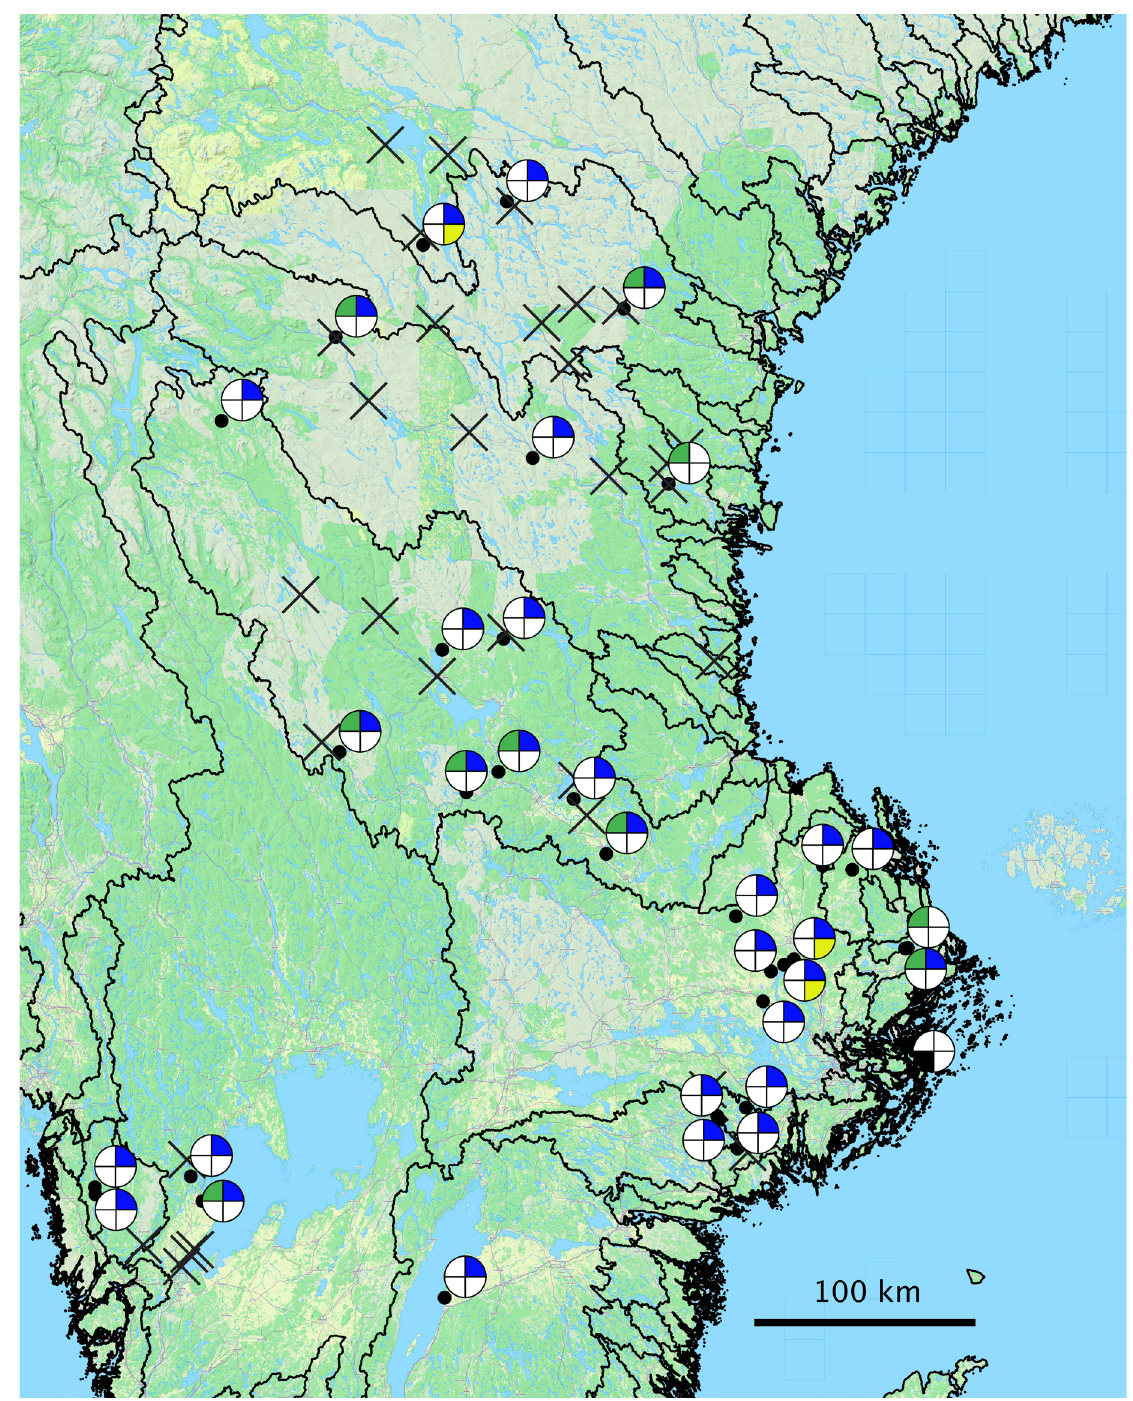
Fig. 1. Sampling sites and species found in main catchment areas in Sweden. Black lines represent watersheds between catchment areas, from the Swedish Meteorological and Hydrological Institute SVAR database (Westman et al. 2017). Crosses are sites visited but where no sponge was found, dots are sites where sponges were collected. The neighbouring pie icon indicates the species present at that site: blue (top right) is Spongilla lacustris (Linnaeus, 1759), yellow (bottom right) Eunapius fragilis (Leidy, 1851), black (bottom left) Ephydatia fluviatilis (Linnaeus, 1759) and green (top left) Ephydatia muelleri (Lieberkühn,